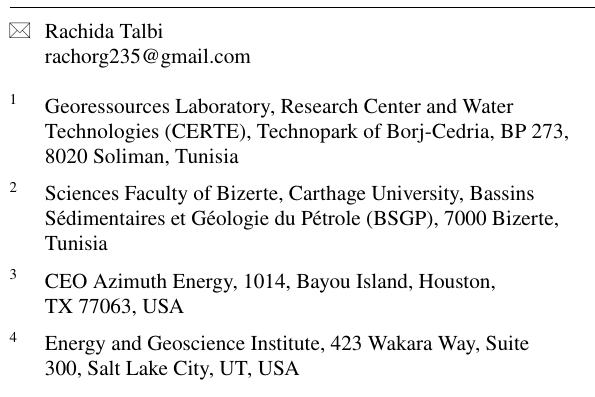
Fig. 4 HI/OI diagram showing the representative points of (Corel Draw figure exported into jpeg format) The original article has been